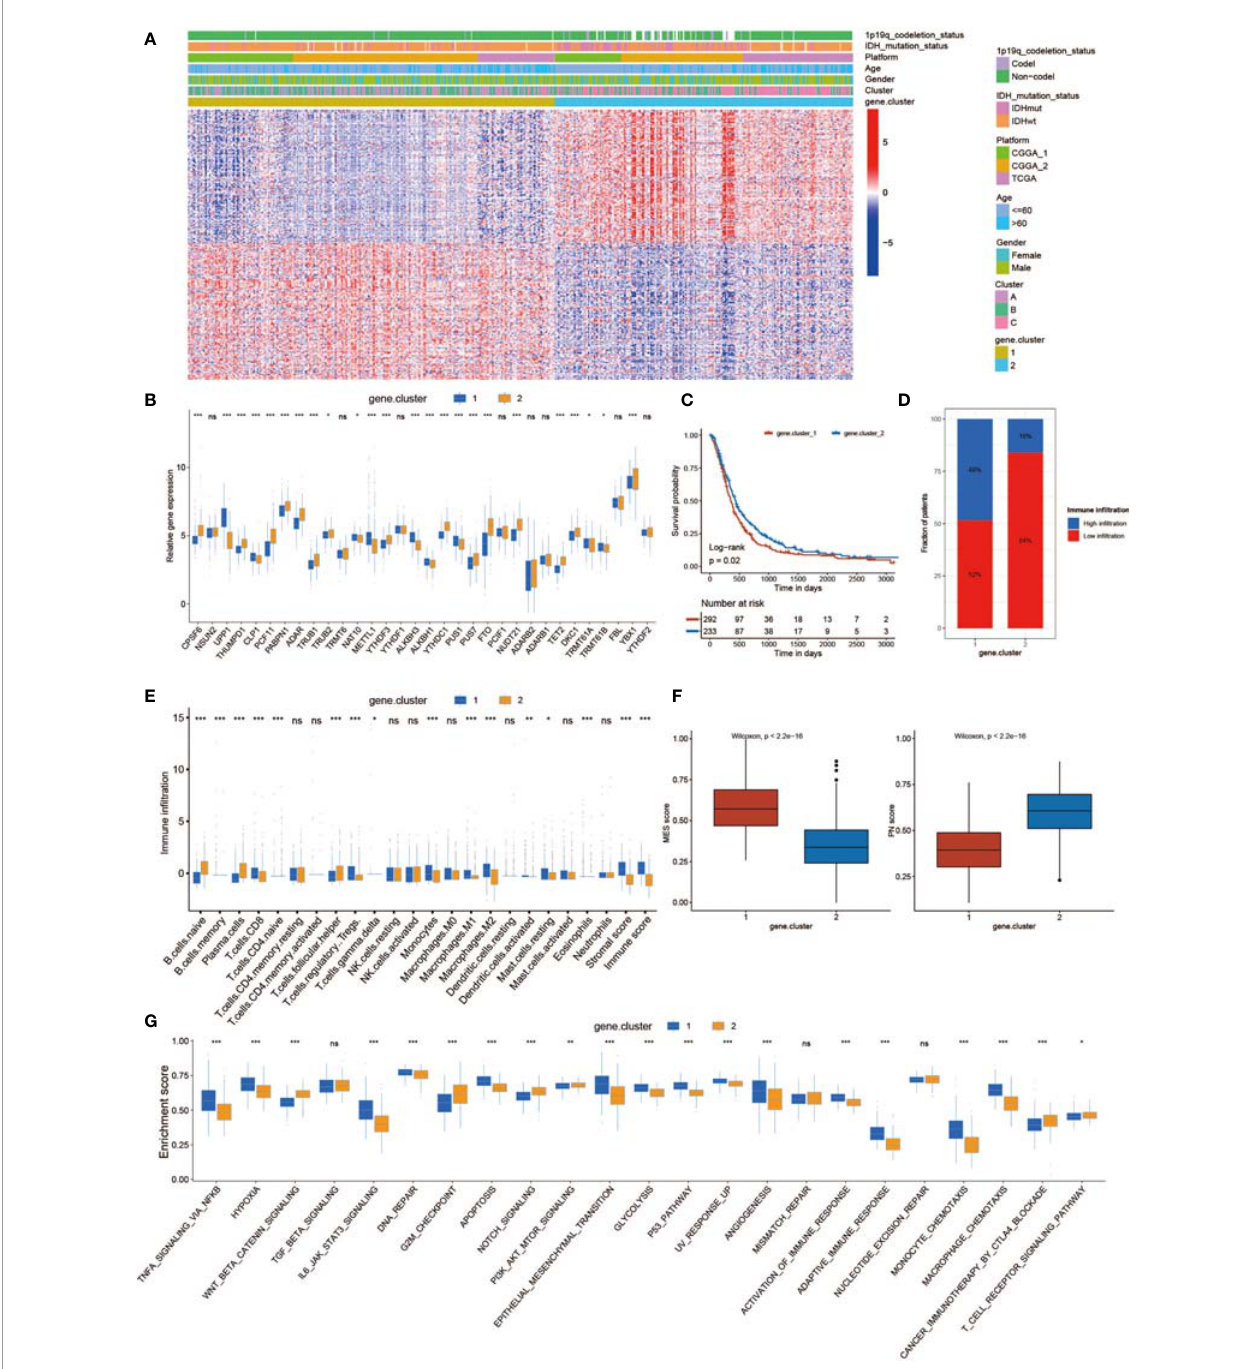
FIGURE 5 | Generation of a non-m 6 A RNA modi fi cation-related gene set. (A) Unsupervised clustering of 150 DEGs dividing patients into two gene.clusters, named gene.cluster_1 and gene.cluster_2. Cluster, gender, age, platform, IDH status, and 1p19q status were applied for sample annotation. (B) The expression of 32 non- m 6 A RNA modi fi cation regulators in two gene.clusters. (C) Survival analyses for the gene.cluster_1 (292 cases) and gene.cluster_2 (233 cases) cohorts ( p = 0.02, log-rank test). (D) The proportion of immune in fi ltration in the two gene.clusters. (E) The abundance of each TME-in fi ltrating cell, stromal scores, and immune scores in the two gene.clusters. (F) Differences in MES/PN scores among the two gene.clusters. (G) Differences in the TME in fi ltration and MES transition pathways between the two gene.clusters. * means P<0.05; ** means P<0.01; *** means P<0.001; ns means